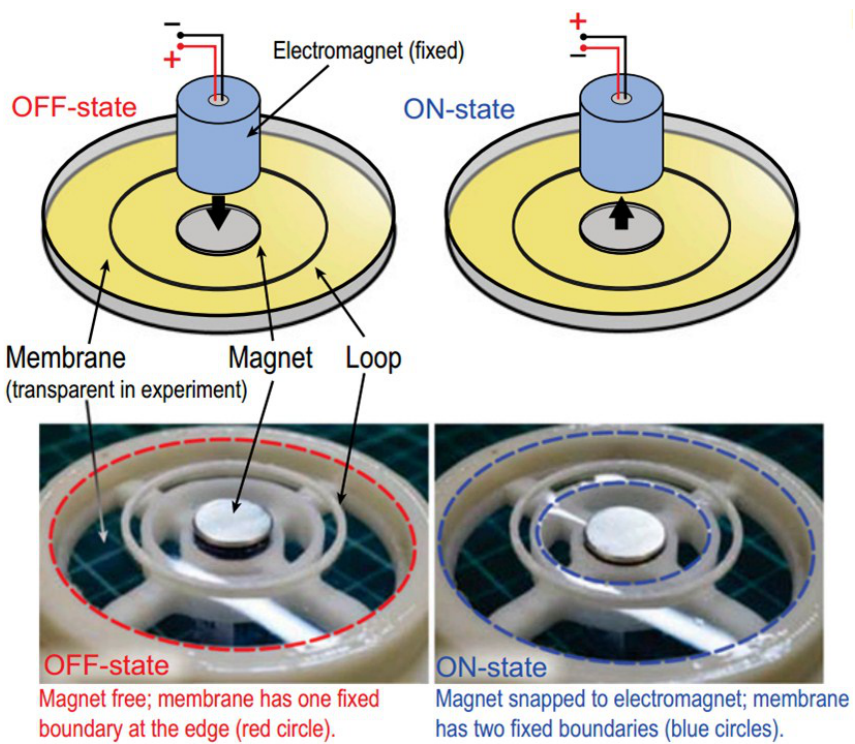
Figure 8. The unit cell design of the structure. Reproduced under a Attribution–Non-Commercial–No